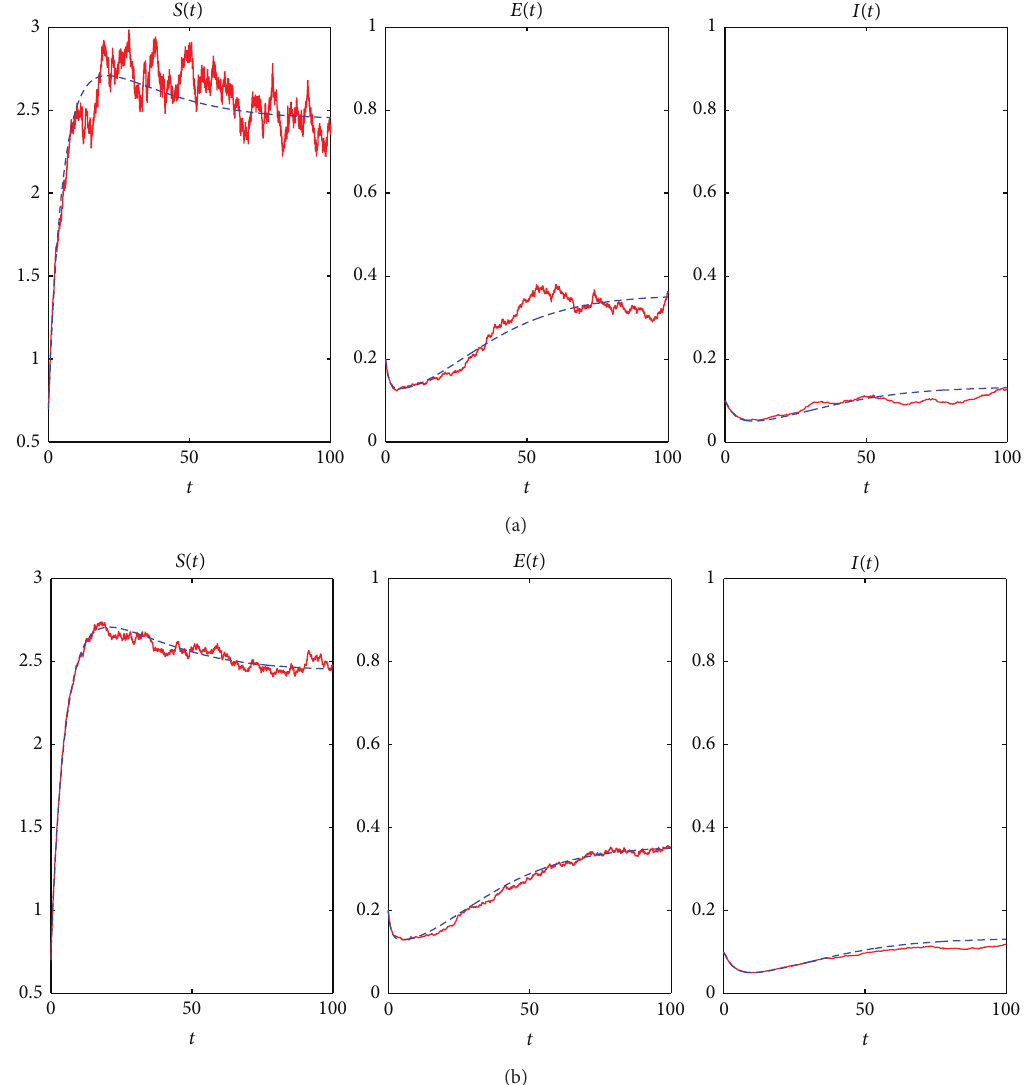
Figure 3: 𝑆(0) = 0.7 , 𝐸(0) = 0.2 , 𝐼(0) = 0.1 , Λ = 0.6 , 𝛽 = 0.6 , 𝜇 = 0.2 , 𝛿 = 0.1 , 𝛾 = 0.2 , 𝜖 = 0.15 , 𝑑 = 0.1 , and Δ𝑡 = 0.002 . Group (a) 𝜎 1 = 0.04 , = 0.03 , and 𝜎 = 0.02 . Group (b) 𝜎 𝜎 2 3